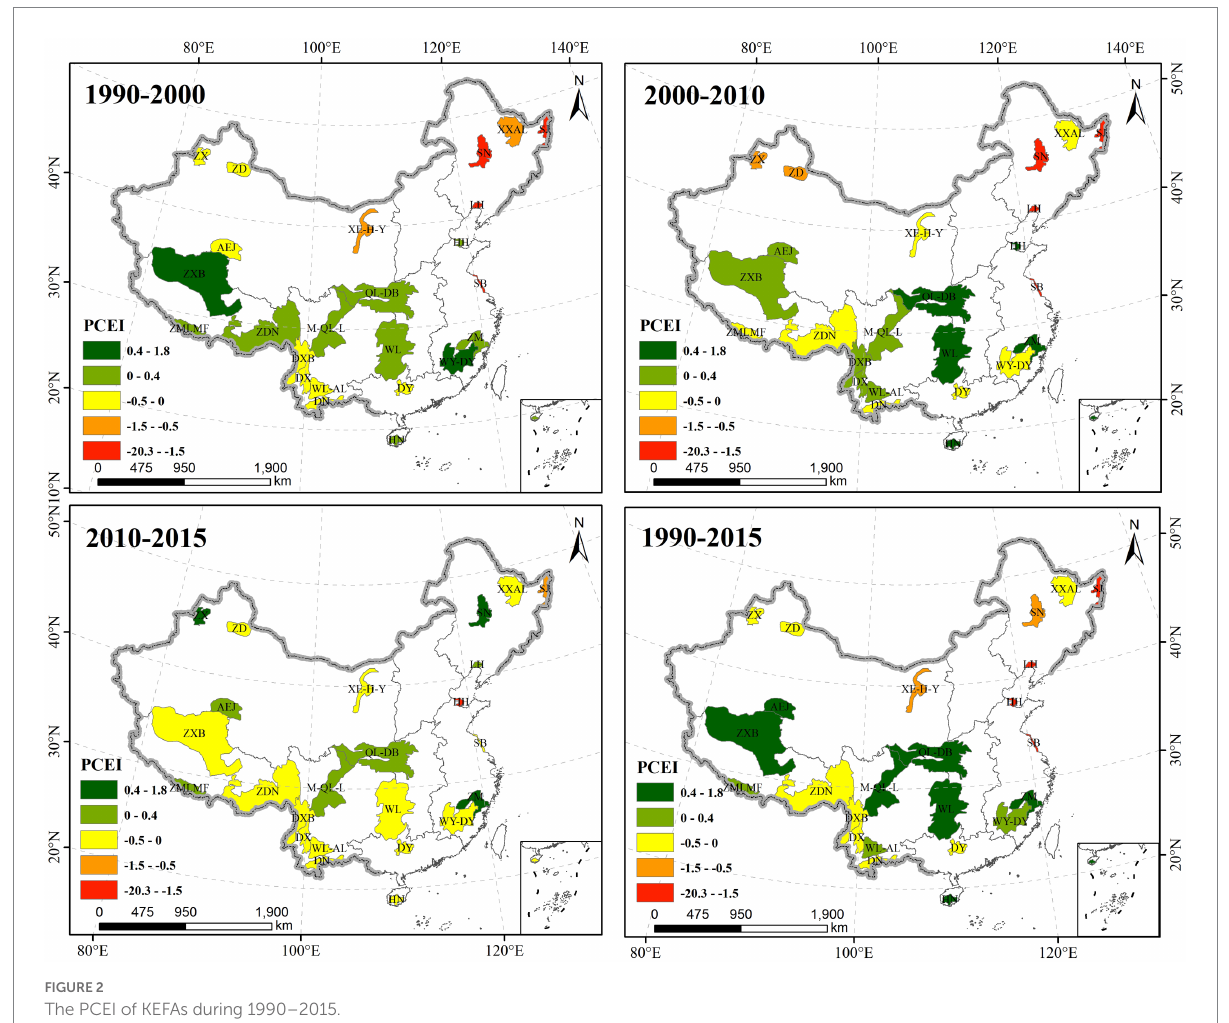
FIGURE 2 The PCEI of KEFAs during